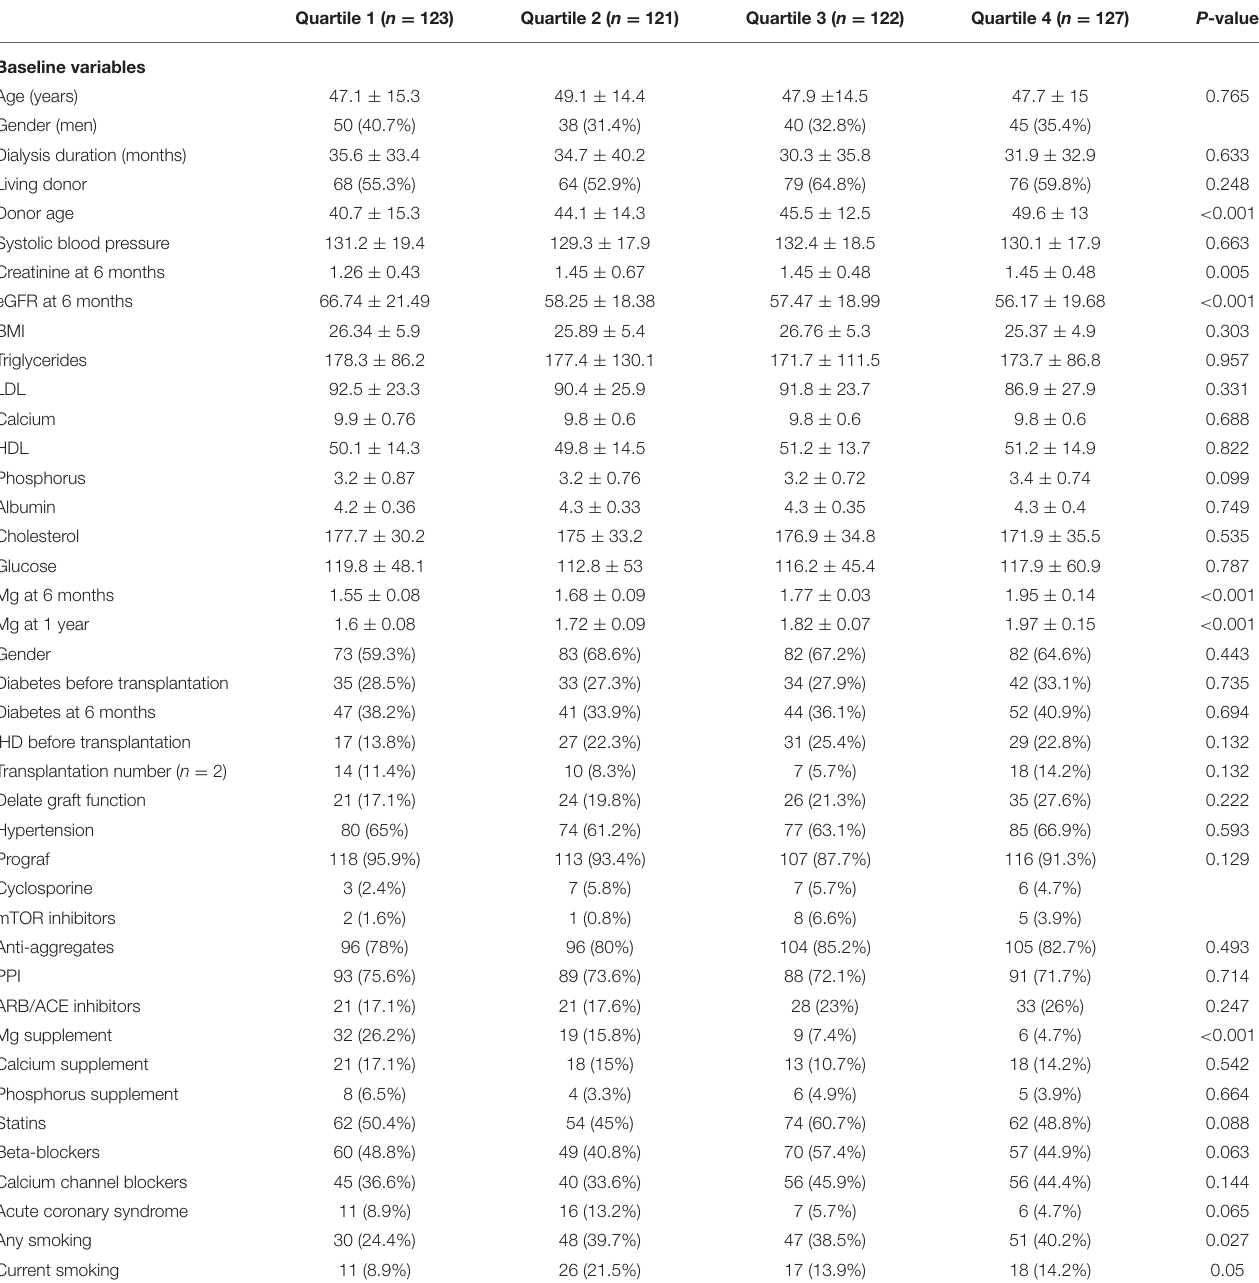
TABLE 1 | Baseline characteristics of the entire study population according to TWA quartiles of sMg during the first 6 months post-transplantation. Quartile 1 ( n = 123) Quartile 2 ( n = 121) Quartile 3 ( n = 122) Quartile 4 ( n = 127) P